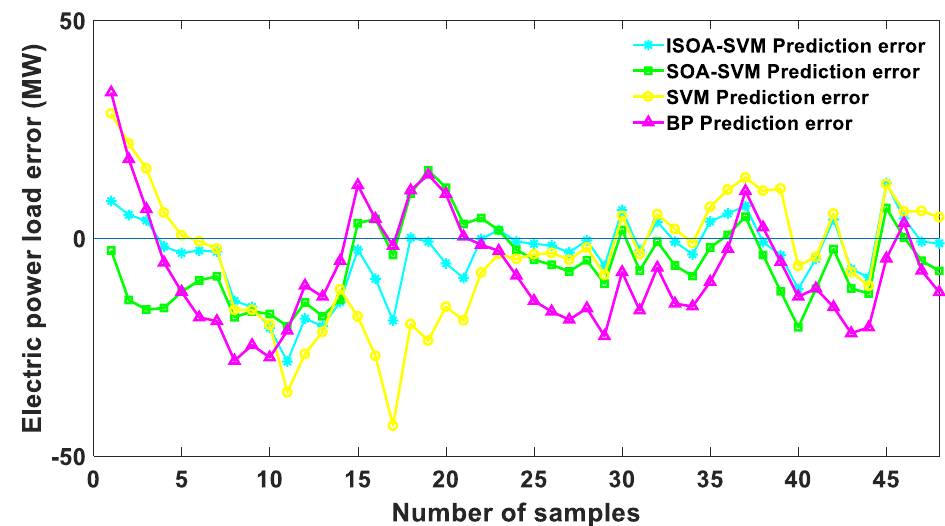
Figure 5. Power load forecasting results of four models for Case 2.